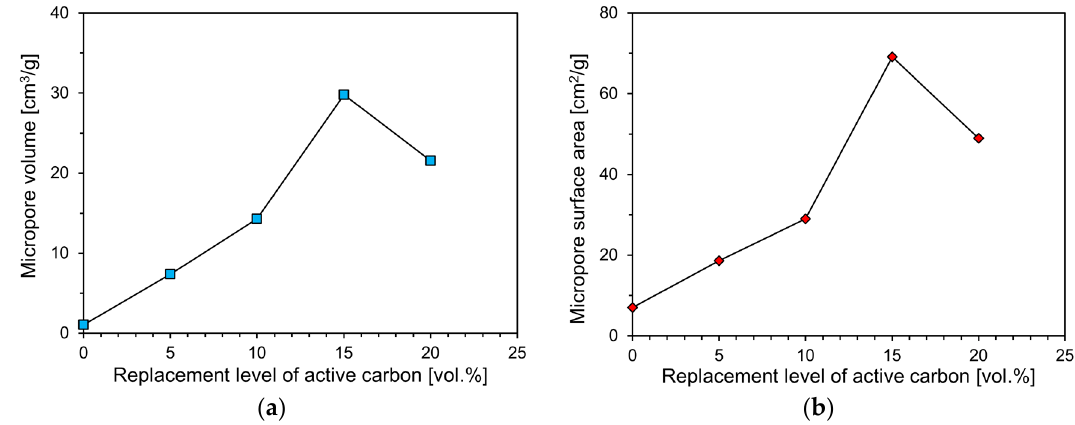
Figure 11. Micropore volume and surface area of specimens according to active carbon content. ( a ) Micropore volume; ( b ) Micropore surface area.